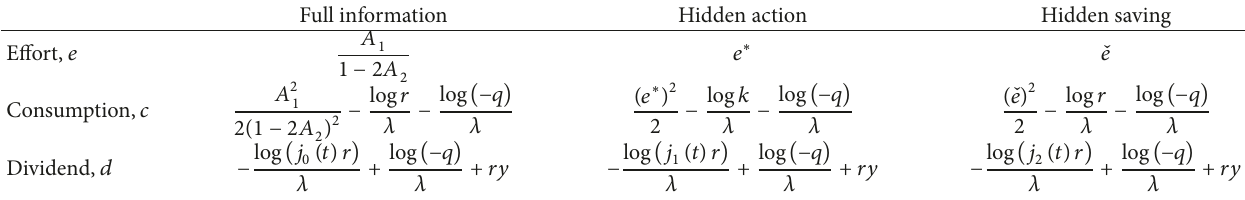
Table 1: Comparison of the policies for the optimal contracts under full information, hidden actions, and hidden